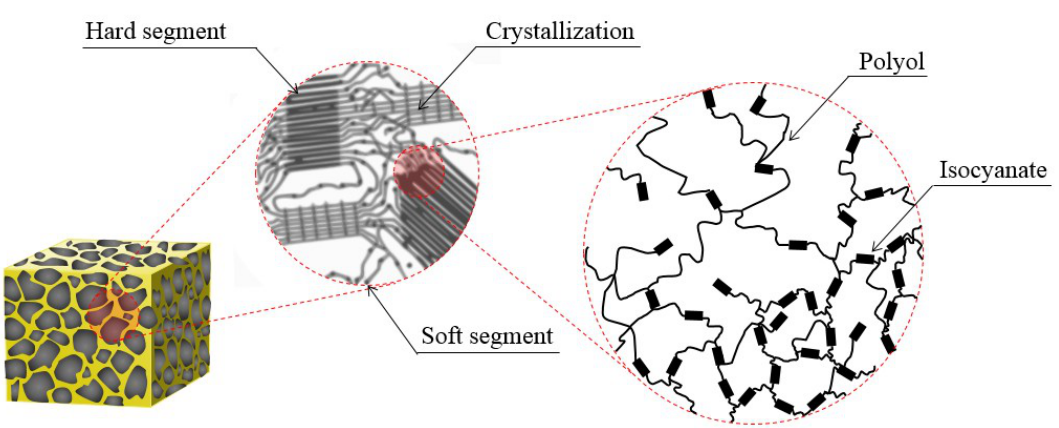
Figure 1. Domain structure that forms the inside the polyurethane foam (PUF).